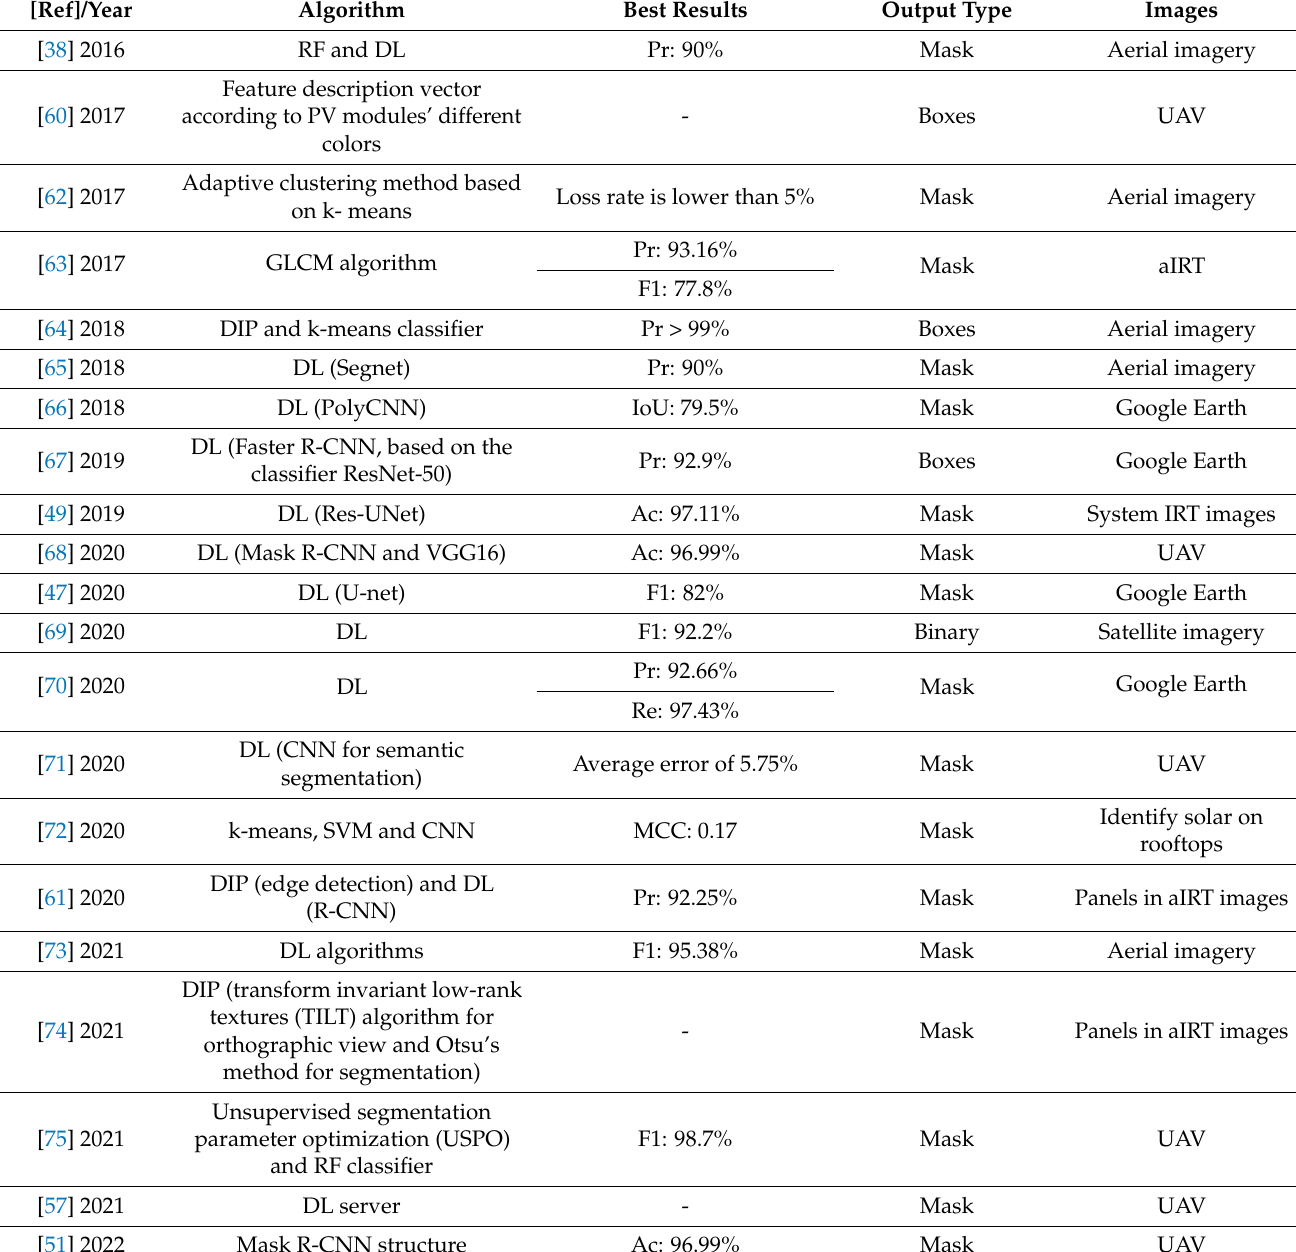
Table 2. Summary of methods for detecting PV systems using aerial